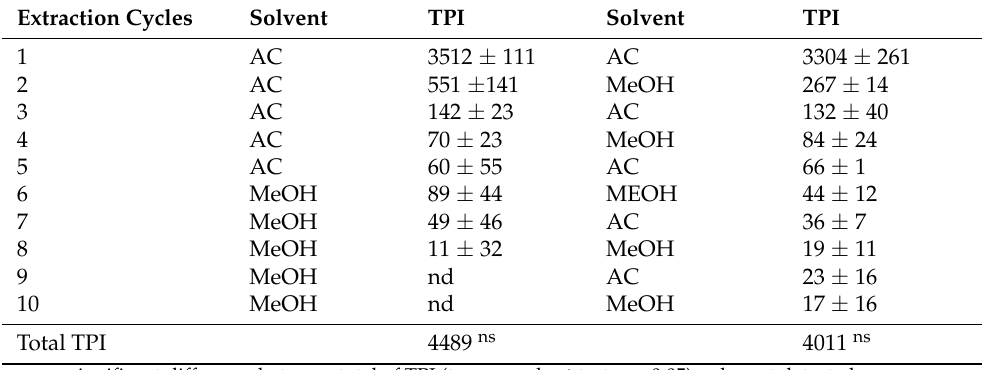
Table 2. Determination of total phenolic index (TPI) in 1 g of lyophilised grape seed powder extracted with accelerated solvent extraction at 10.3 MPa and room temperature, ten times with one extraction cycle (EC) and 15 min static time (ST). Left—the EC was performed five times with 80% aqueous acetone (AC) and then five times with 60% aqueous methanol (MeOH). Right—AC and MeOH were exchanged after each EC. The results represent means of three replicates ± standard deviation. Extraction Cycles Solvent